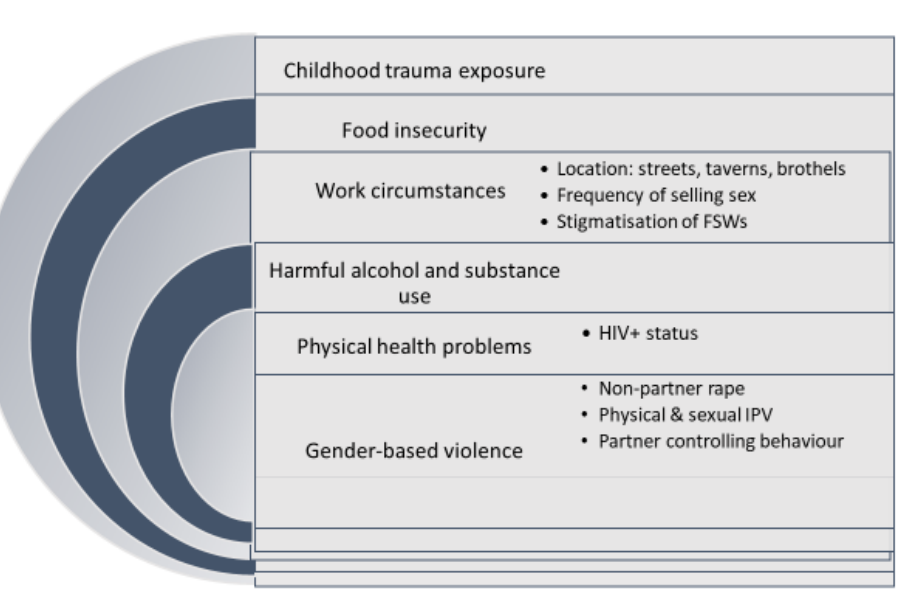
Figure 1. Conceptual model of factors associated with mental ill-health amongst FSWs.